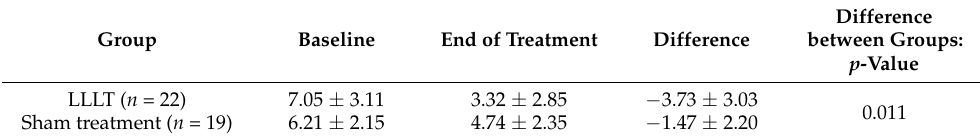
Table 4. Treatment effects (TNSS, mPP set).